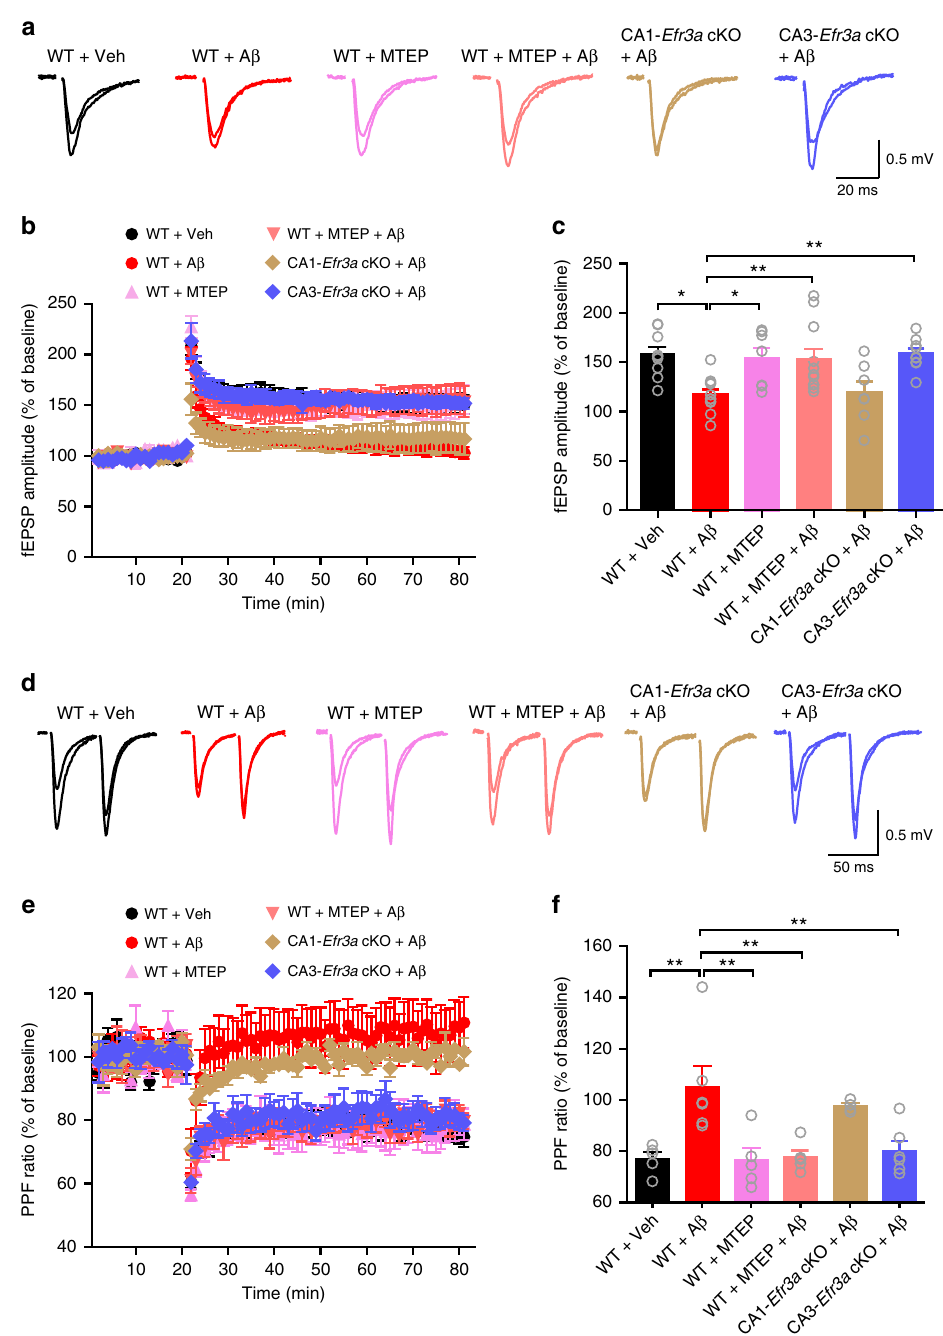
Fig. 9 Blocking mGluR5 with MTEP or selectively knocking out Efr3a in the CA3 area ameliorates oligomeric A β -induced impairment of a presynaptically- expressed LTP at the SC-CA1 synapse. a Representative traces showing averaged fEPSPs recorded in CA1 area 10 min before and 50 min after high- frequency SC stimulation (superimposed) in WT slices treated with vehicle (WT + Veh), oligomeric A β (WT + A β ), MTEP (WT + MTEP), or both MTEP and oligomeric A β (WT + MTEP + A β ), or in oligomeric A β -treated hippocampal slices from mice selectively knocking out Efr3a in the CA1 (CA1- Efr3a cKO + A β ) or CA3 (CA3- Efr3a cKO + A β ) area. b The time course of the normalized amplitude of fEPSPs before and after an LTP induction protocol in conditions shown in a . c Bar graph representing mean LTP magnitude 50 min after LTP induction shown in b . One-way ANOVA with post hoc Dunnett ’ s test; F (5,48) = 5.171; * P < 0.05; ** P < 0.01; N = 7 – 11 per group. d Representative traces of PPF of fEPSPs recorded in the CA1 area 10 min before and 50 min after high-frequency SC stimulation in the same conditions as in a . e The time course of the normalized PPF ratio before and after an LTP induction